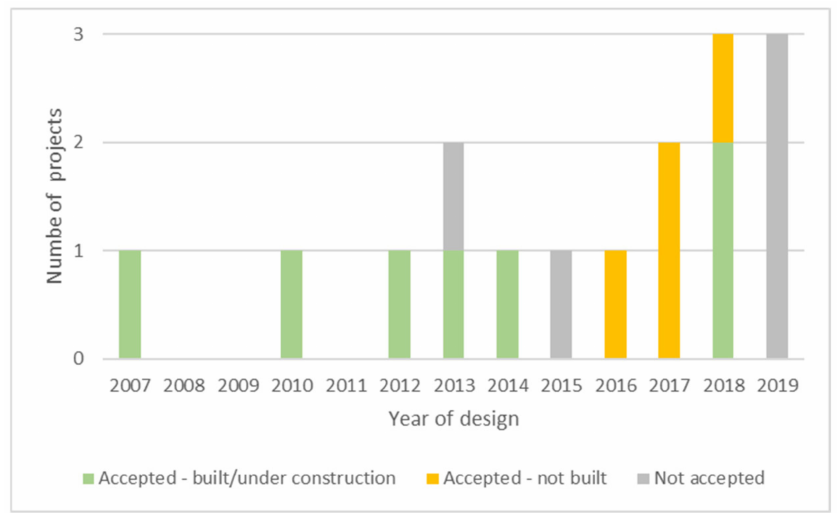
Figure 5. Distribution of the analyzed biomimetic urban projects according to their status and design date.